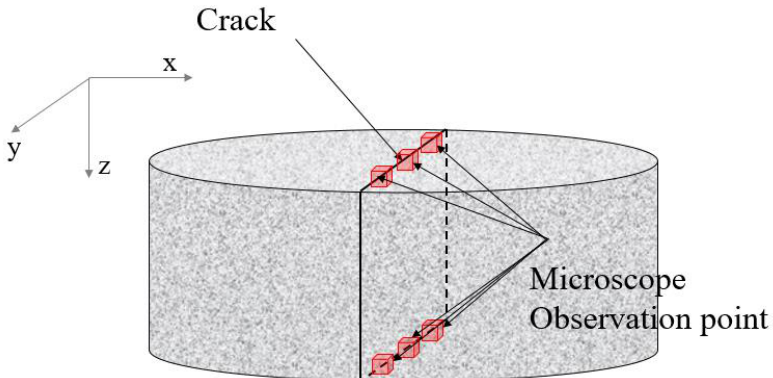
Figure 4. Epoxy coating of specimen.